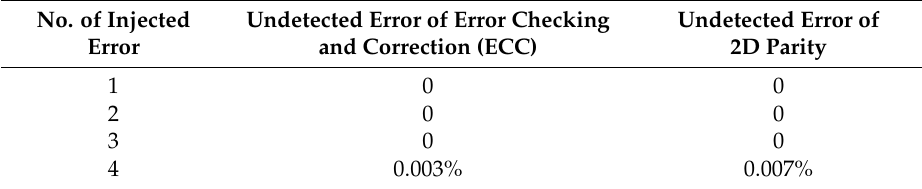
Table 1. Fault injection simulation of ROM size 8 × 32.